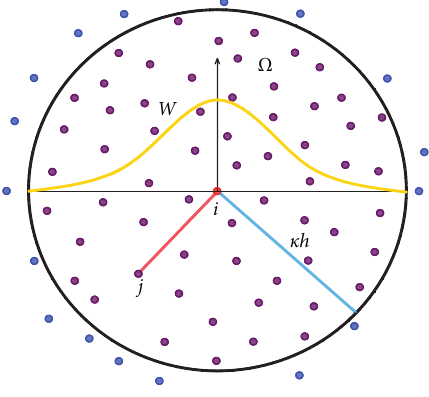
Figure 1: Principle of the SPH